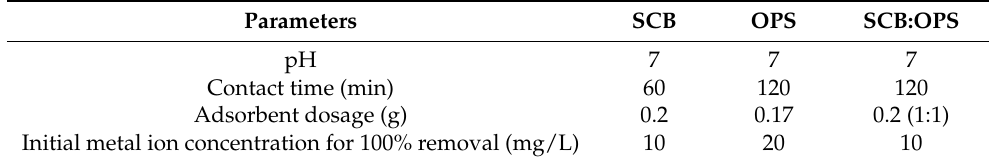
Table 3. Summary of optimum experimental conditions for Pb(II) removal using SCB and OPS individually, and a homogenised combination of SCB and OPS.